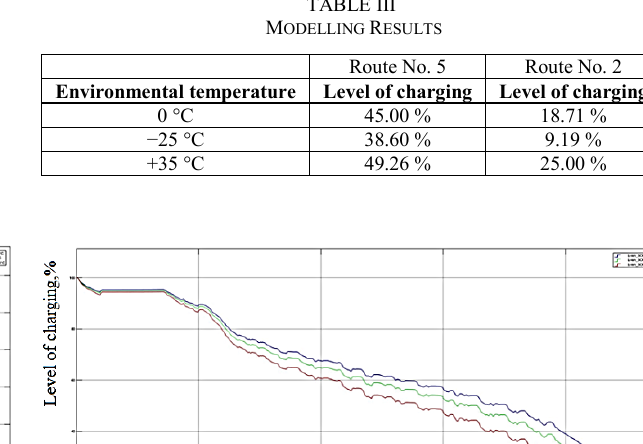
Fig. 9. Voltages of different types of accumulators during the simulation of the same routes correspondently. Green – nickel-metal hydride, red – lead acids; blue – lithium-ion.